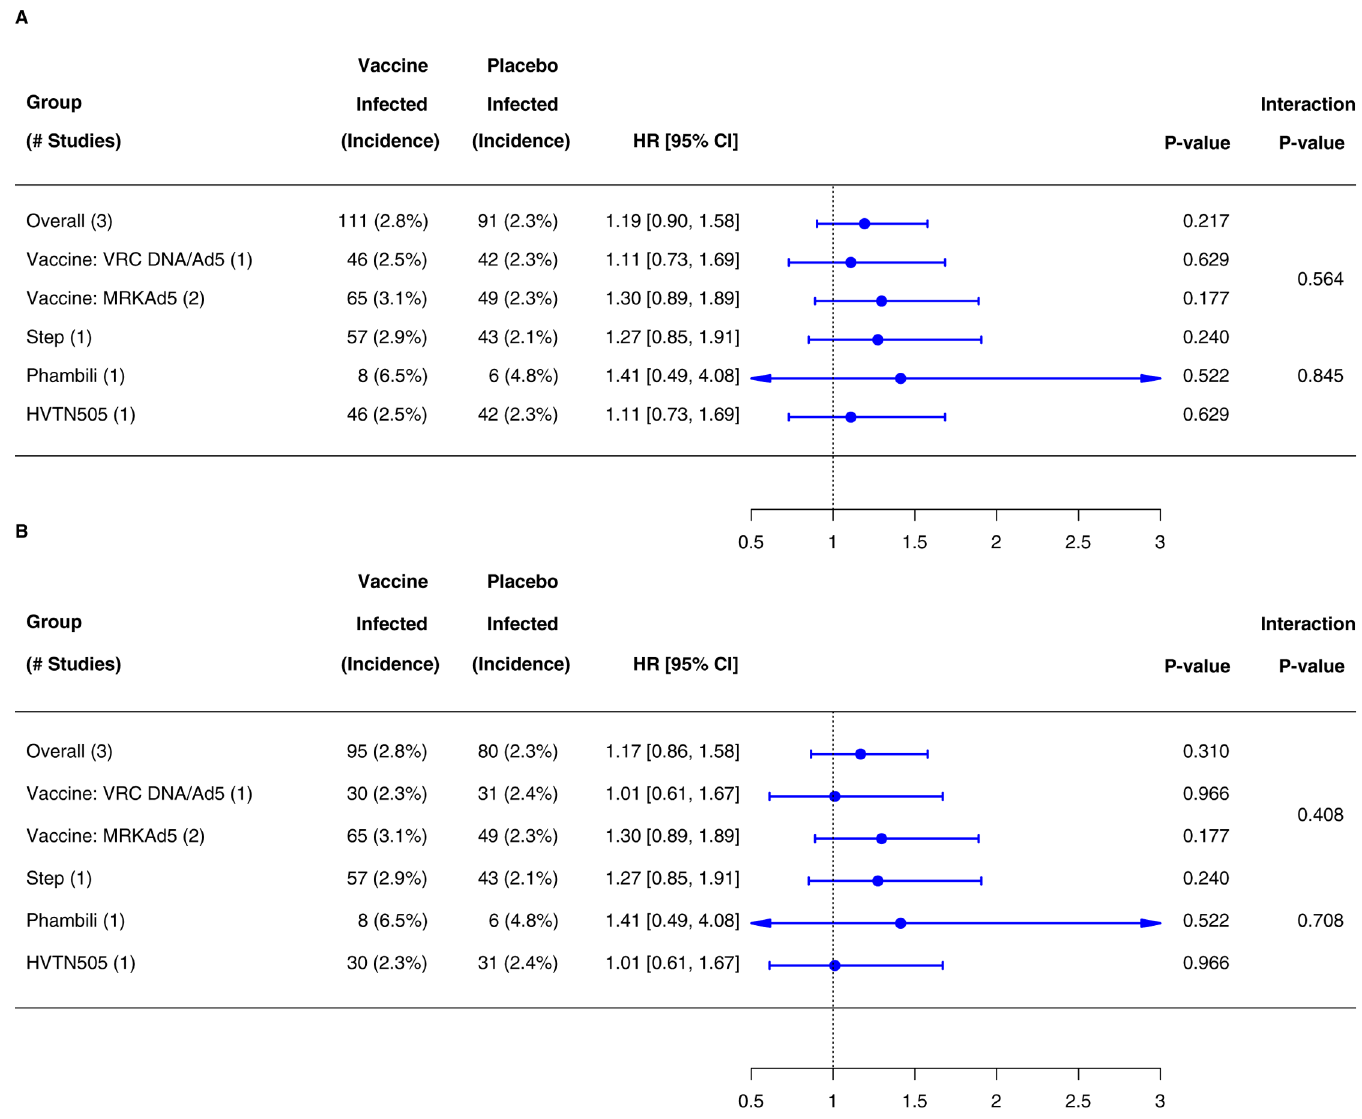
Fig 5. Estimated HRs in the MITT Cohort (Panel A) and Ad5 Cohort (Panel B) Using Follow-up Time before Unblinding Based on Step, Phambili and HVTN505. The MITT cohort included all randomly assigned participants HIV uninfected at study entry, who received at least one dose of vaccine or placebo; the Ad5 cohort included MITT participants who received at least one dose of rAd5-HIV vaccine or rAd5-placebo. Blue lines are 95% confidence intervals indicating HRs not significantly different from